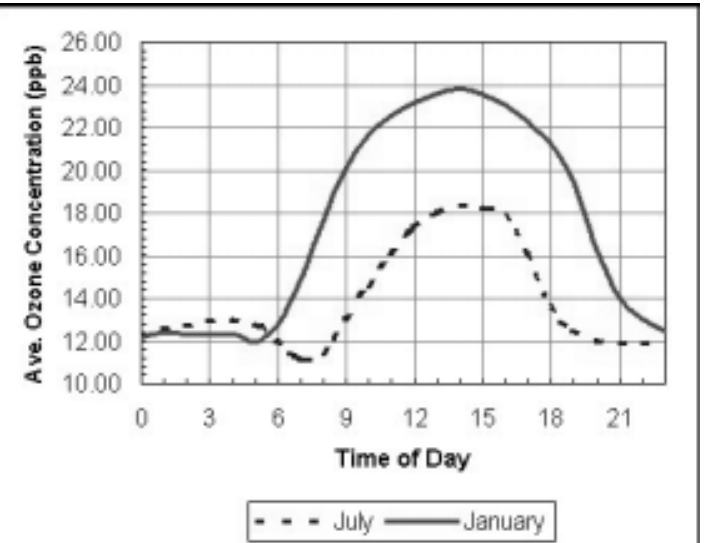
Figure 6. Seasonal comparison of hourly average ozone concentration in